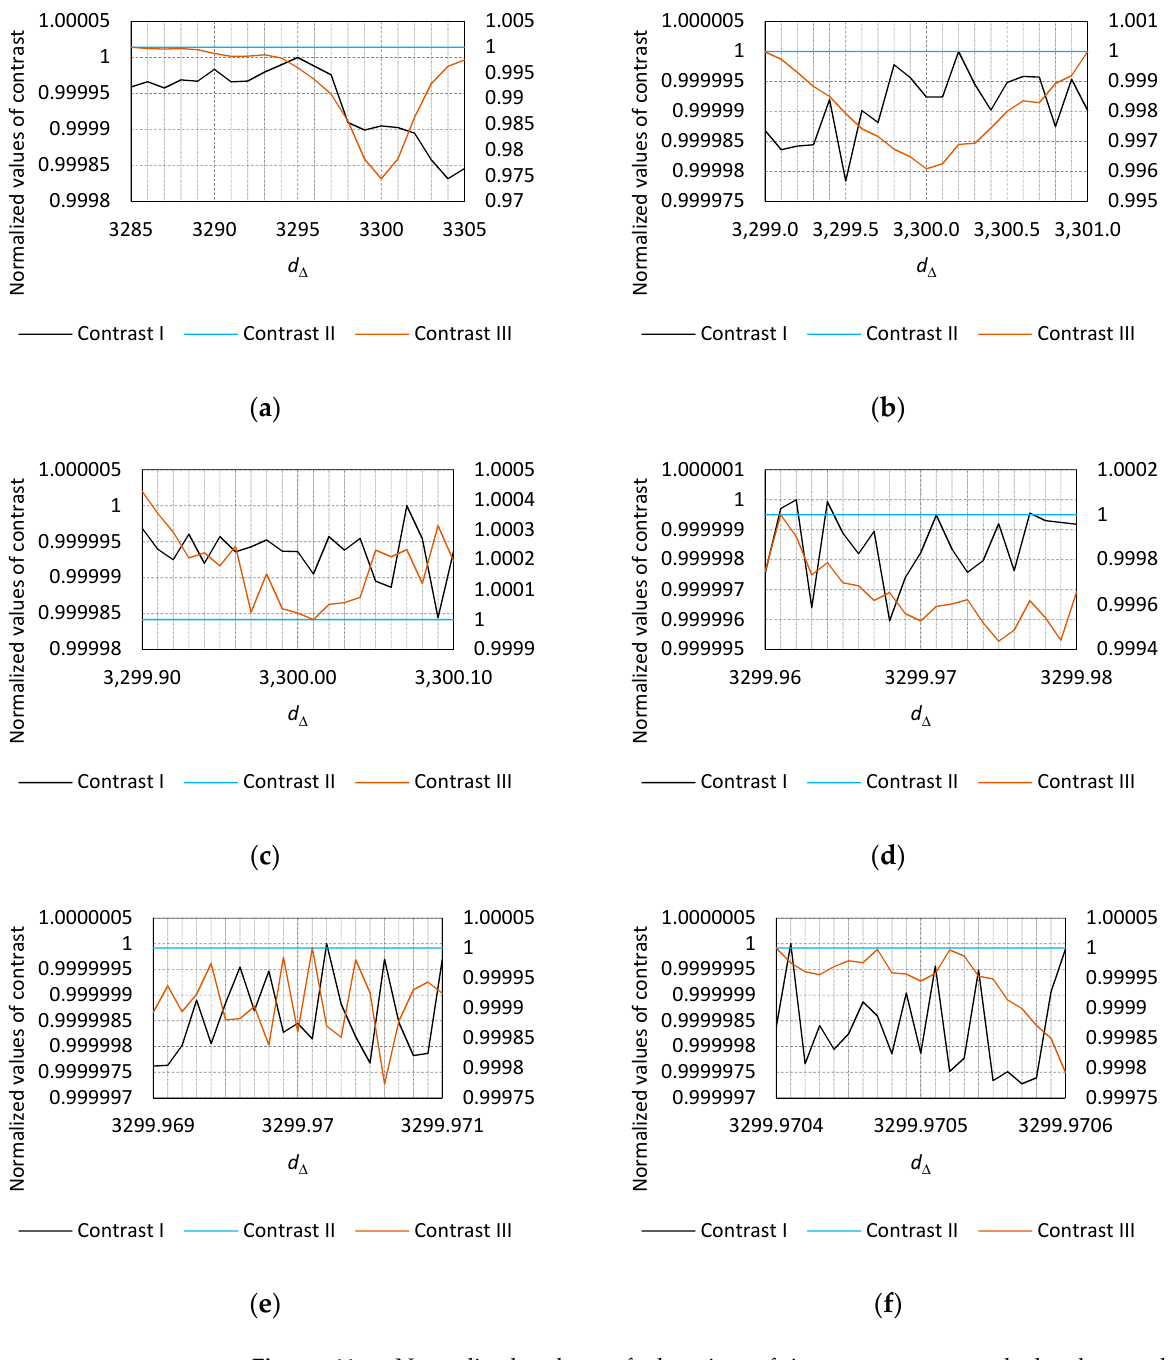
Figure 11. Normalized values of changing of images contrasts calculated according to equations (2), (8) and (11) in domain of image line length 𝑑 ∆ for different accuracies Δ : ( a ) ∆= 1.0 , ( b ) ∆= 0.1 , ( c ) ∆= 0.01 , ( d ) ∆= 0.001 , ( e ) ∆= 0.0001 , ( f ) ∆= 0.00001 , original image Figure 7d